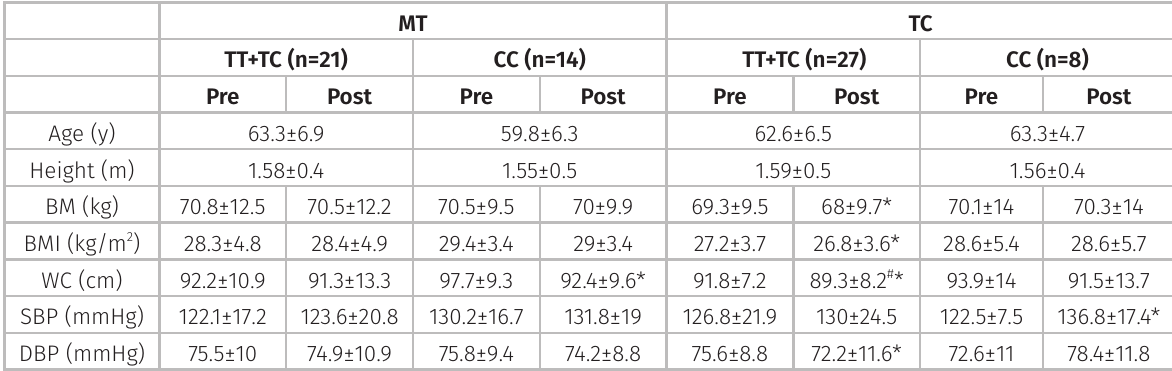
Table V. Anthropometric variables, age, and blood pressure related to ACTN3 polymorphism.